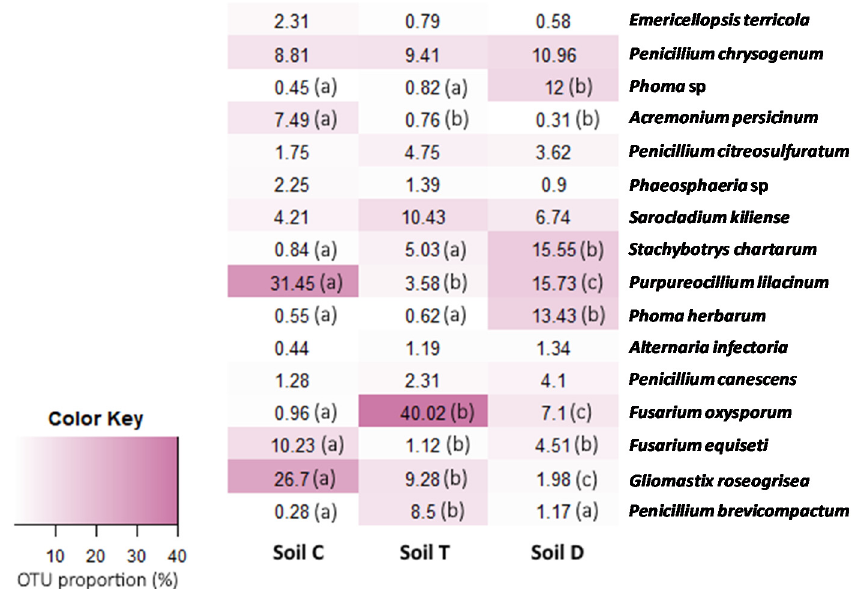
Figure 5. Composition of the common OTUs shared by the three PCB-polluted soils. The proportion of the relative abundance of each OTU was compared two-by-two between the three studied soils using a Chi-squared test ( p -value < 0.05). Different small letters, shown in parentheses, indicate significant differences between values for each OTU.